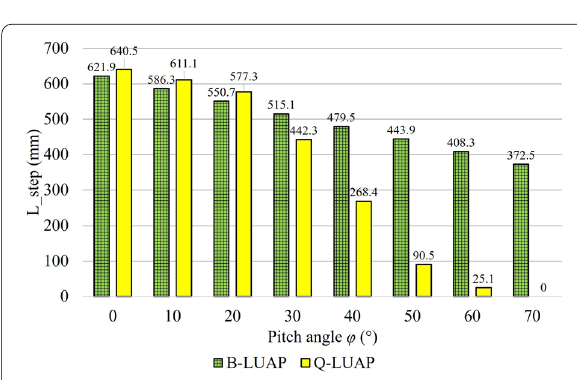
Figure 8 Step length